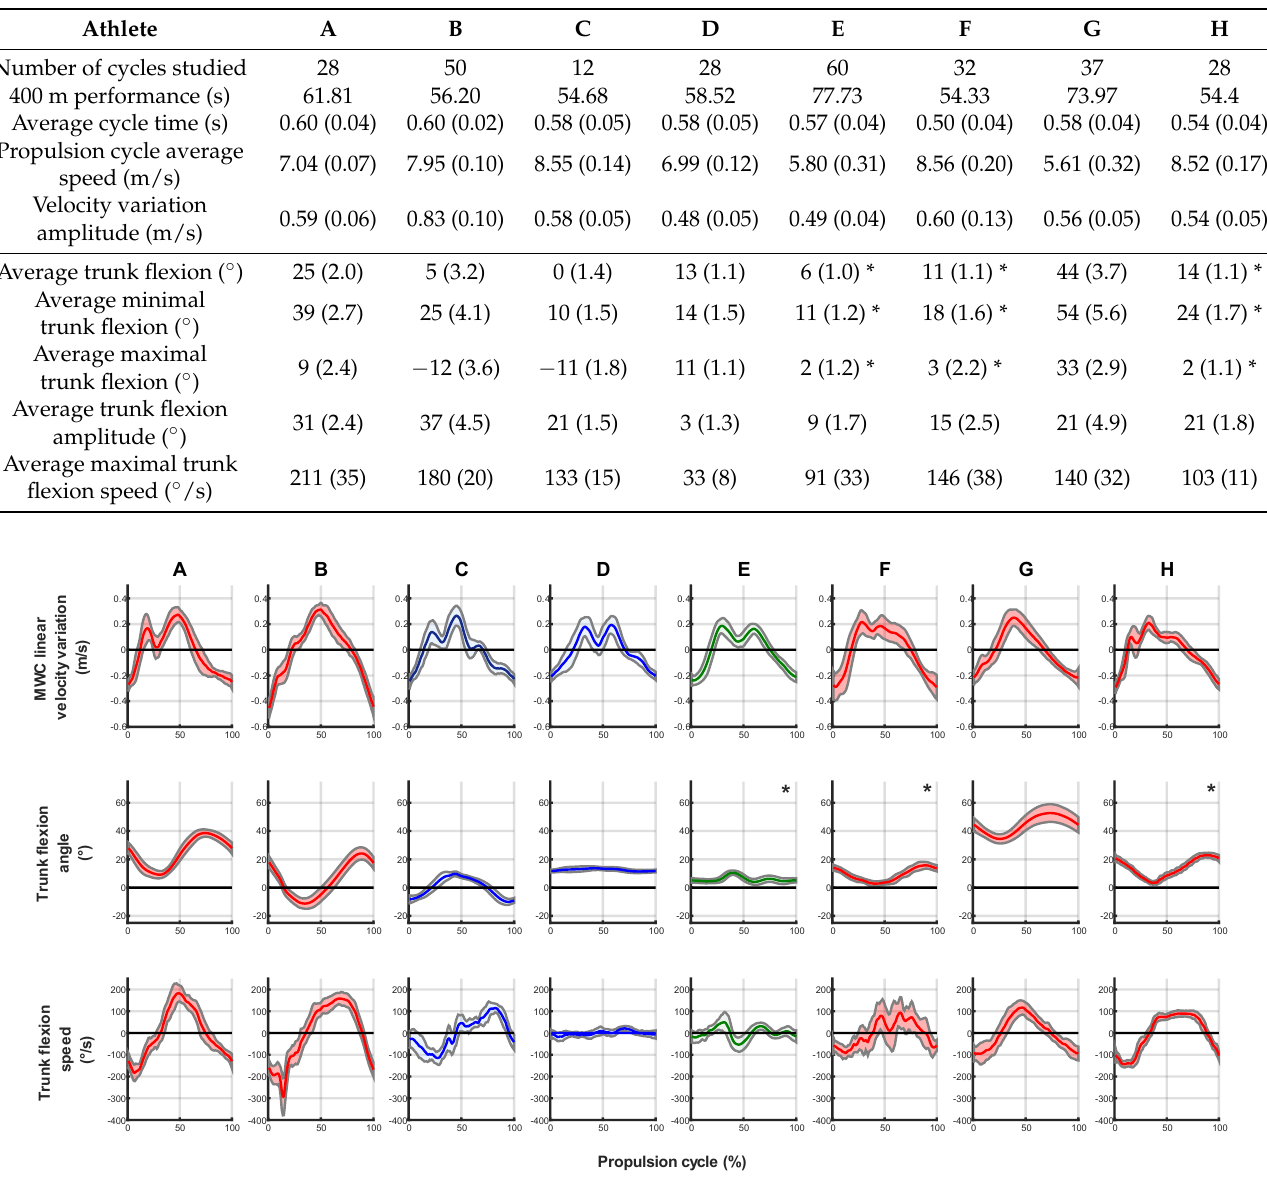
Figure 3. Average propulsion cycle of each athlete. First row: MWC linear velocity (centered on the average cycle speed); Second row: trunk flexion; Third row: trunk flexion speed. The average cycle of each athlete is available as supplementary material. [Red (T54), blue (T53) and green (T52) line = mean over all cycles identified per athlete; shaded corridor = mean ± 1 std; *: data with a potential offset due to the visual estimation of the initial inclination of the IMU placed on the trunk].